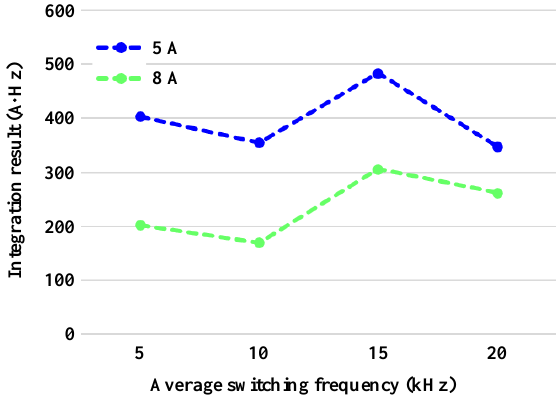
Figure 8. Integral results from 5 kHz to 40 kHz for Figure 7.